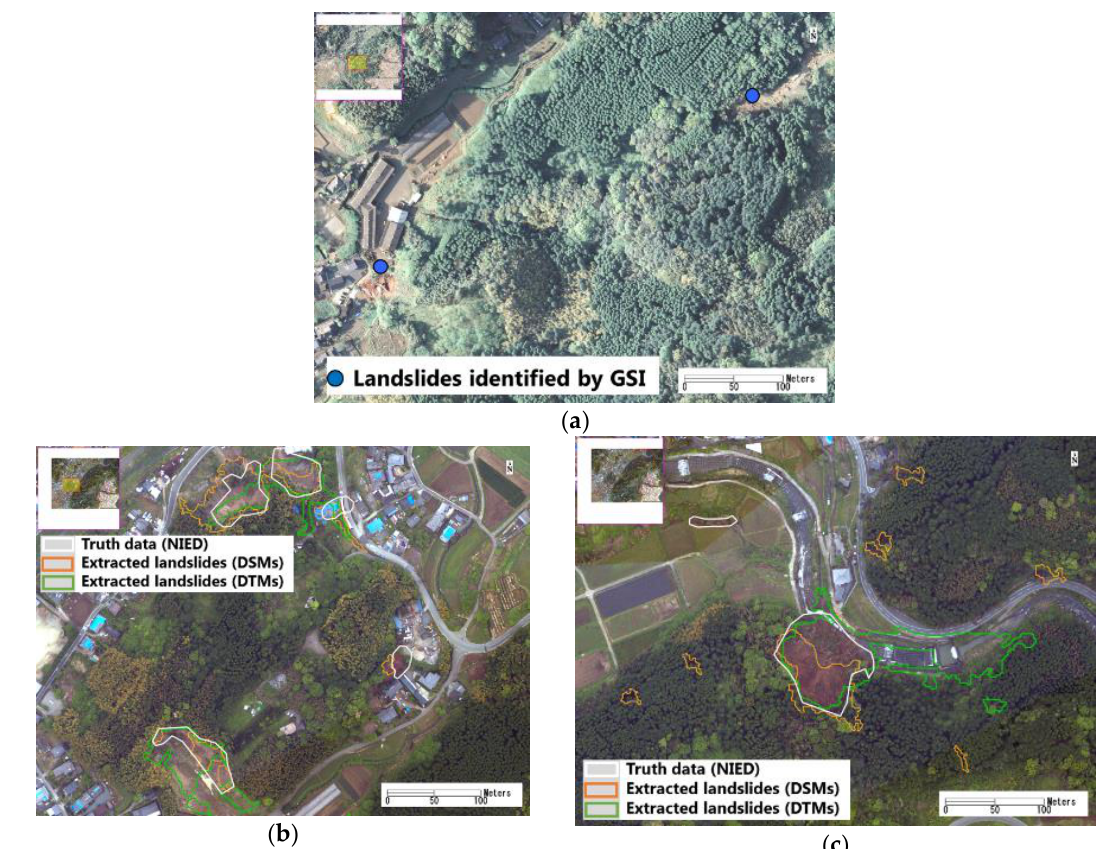
Figure 12. Three enlarged areas for comparisons: ( a ) The locations of the two landslides that occurred before the main shock, overlapping the 15 April 2016, aerial photo; ( b , c ) comparisons of the detected landslide regions and the landslides traced by NIED, where the background is the 23 April 2016, aerial photo. Table 2. Comparison of the detected results with the landslides identified by Table 3. Comparison of the detected results with the landslides identified by NIED.